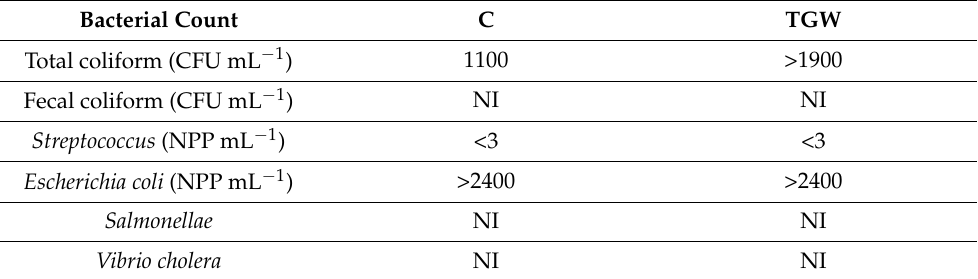
Table 4. Effect of treated grey water irrigation on soil microorganism’s content. Bacterial